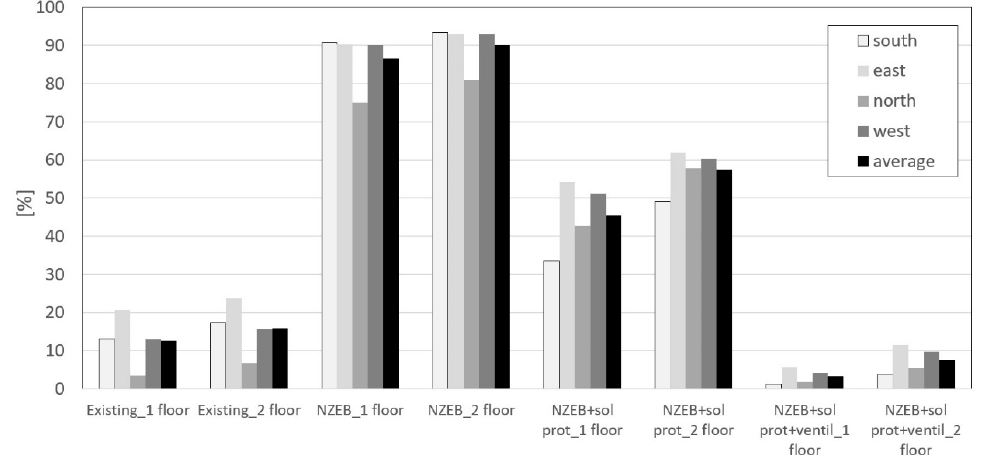
Figure 5. Relative discomfort hours of the different building configurations in Milan.